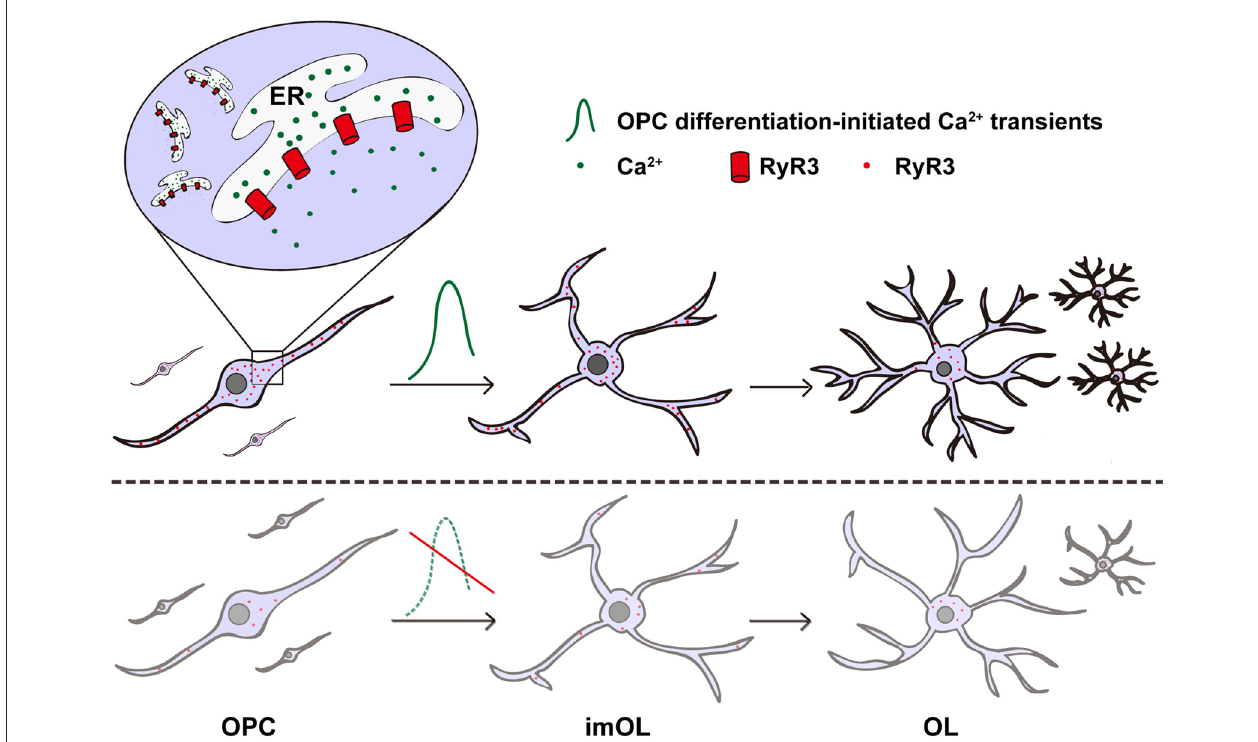
FIGURE 5 | Scheme illustrating the contribution of RyR3-mediated Ca 2 + signaling during oligodendroglial development. RyR3, a Ca 2 + -induced Ca 2 + release (CICR) channel located on the ER membrane during oligodendroglial differentiation, note that it is widely distributed in the cell body and processes of OPC/imOLs but down-regulated and restricted in the cell body of mature OLs. The initiation of OPC differentiation requires hyperactive Ca 2 + signaling mediated by RyR3. RyR3 knockdown or blockage of RyR3-mediated Ca 2 + signaling in OPCs results in inhibition of OPC differentiation.